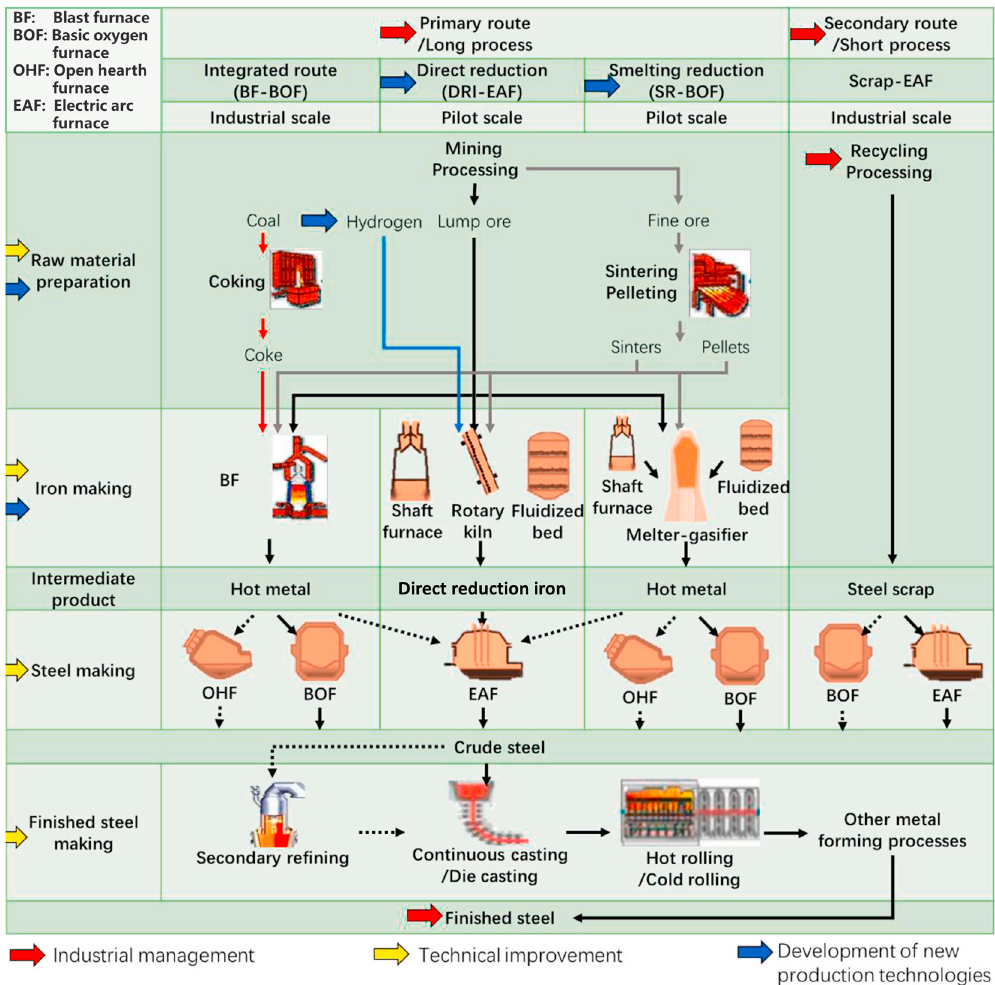
Figure 1. Typical steelmaking procedures [12].